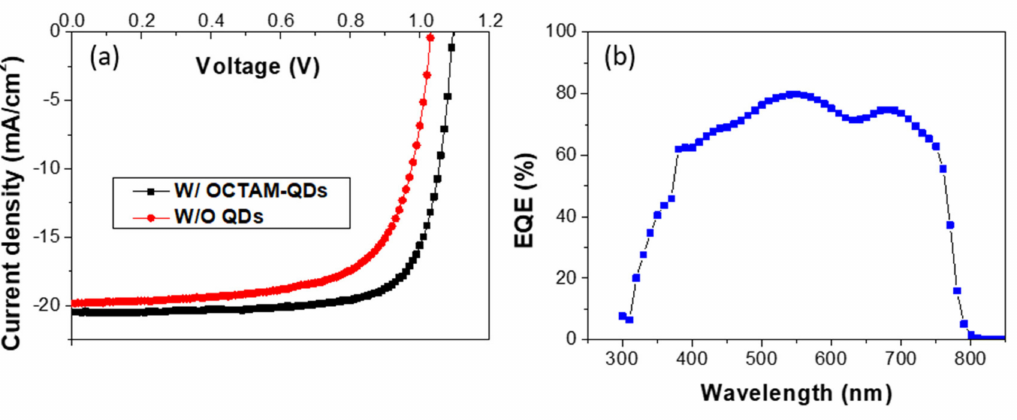
Figure 3. ( a ) J-V characteristics for PSCs and ( b ) EQE spectrum of the PSC with QDs using Octam